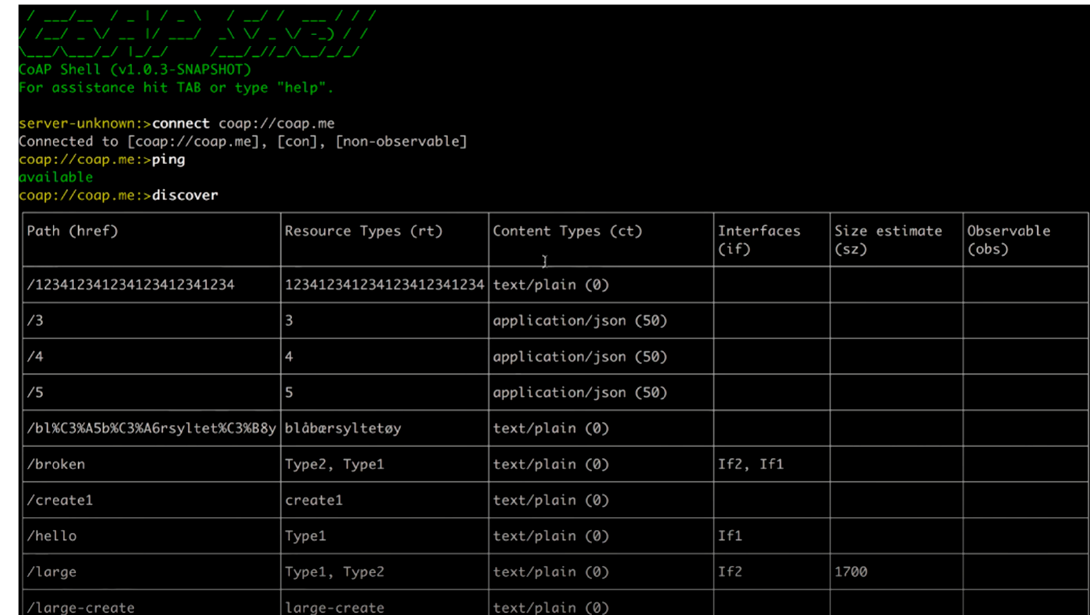
Figure 22. CoAP response to the provided GET method. Within the context of this work, there are interesting possibilities, such as testing the routes and adding new devices (e.g., add_device with POST method). The device information is contained in the payload, where the JSON format is required (see Figure 23). Figure 23. Adding a new device results in the corresponding message: new device added. The available information is the token through which the call is made, the duration of the which (round trip time (RTT)) is 13 ms in the example, and the return status code